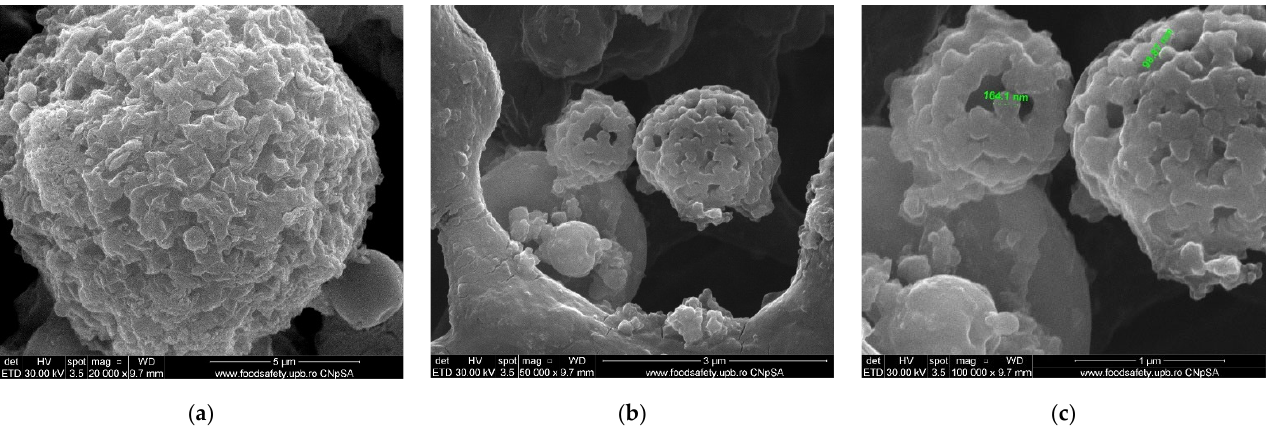
Figure 6. Scanning electron microscopy (SEM) images of the membrane nanodispersion, at magni ‐ tudes of: ( a ) ×20,000; ( b ) ×50,000; and ( c ) ×100,000.